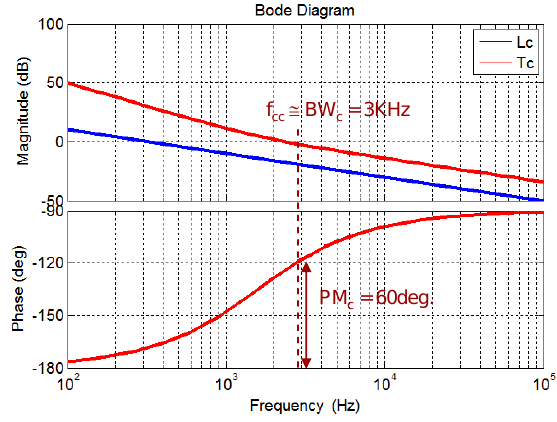
Figure 7. Small-signal equivalent circuit of the current loop.